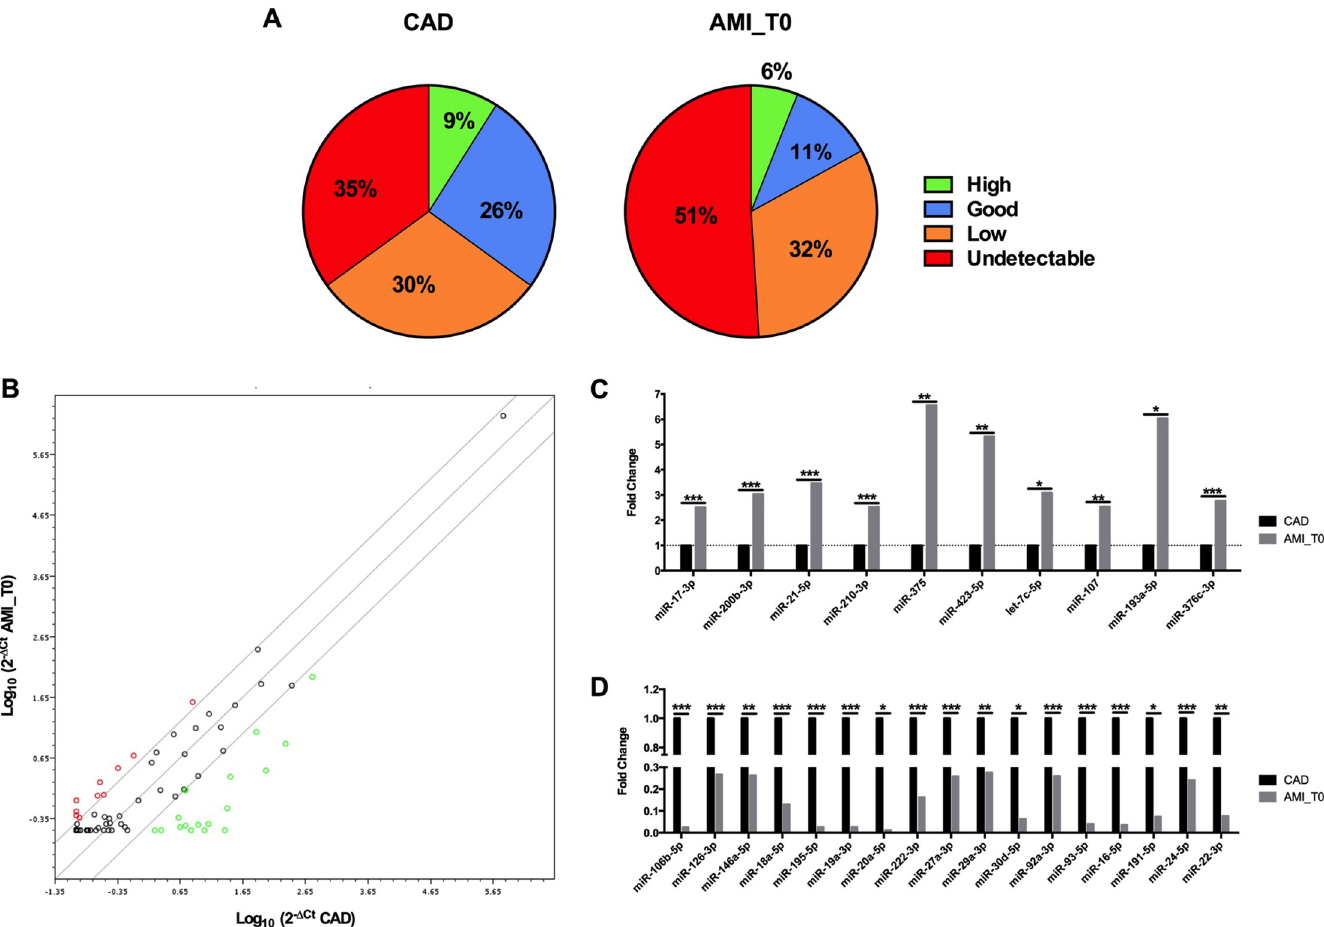
Fig 1. MiRNA PCR Array results. ( A) MiRNA signature in CAD and AMI_T0 pools. MiRNAs expression is classified as high (Ct < 25), good (Ct range 25–30), low (Ct range 30–35) and undetectable (Ct > 35). (B) Scatter plot of 2 - Δ CT values showing significant differences between mature miRNA expression levels in CAD and AMI_T0. Red dots represent statistically significant up-regulated miRNAs, green dots represent statistically significant down-regulated miRNAs in AMI_T0 and black dots represent miRNAs with a comparable expression between the two plasma pools of patients. In the comparison AMI_T0 vs CAD, (C) 10 miRNAs are up-regulated and (D) 17 down-regulated (n = 3; � p � 0.05, �� p � 0.005, ��� p � 0.0005).